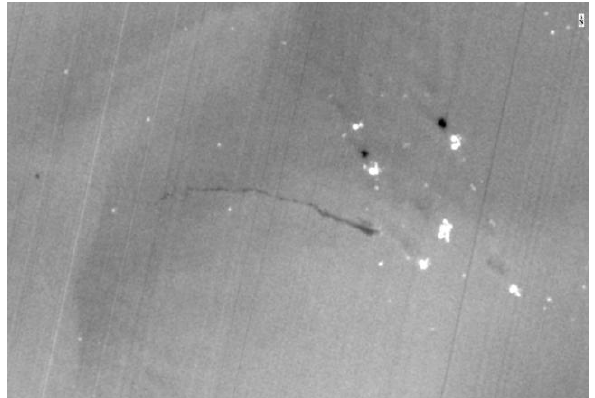
Figure 5c. Intensity image in the TIR domain of field from image 5a.